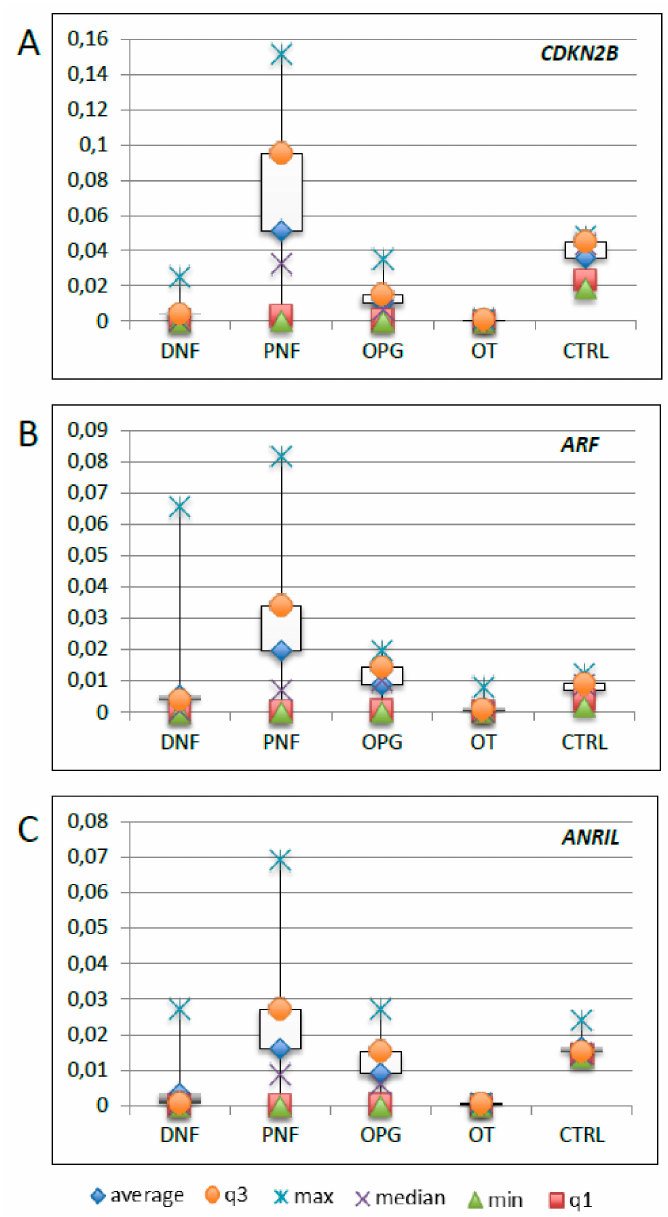
Figure 2. Distribution of CDKN2B ( a ), ARF ( b ), and ANRIL ( c ) gene expression in patients’ peripheral blood mononuclear cells (PBMCs) reported in a box plot. DNF: dermal neurofibroma; PNF: plexiform neurofibroma; OPG: optic pathway glioma; OT: other tumors; CTRL: una ff ected